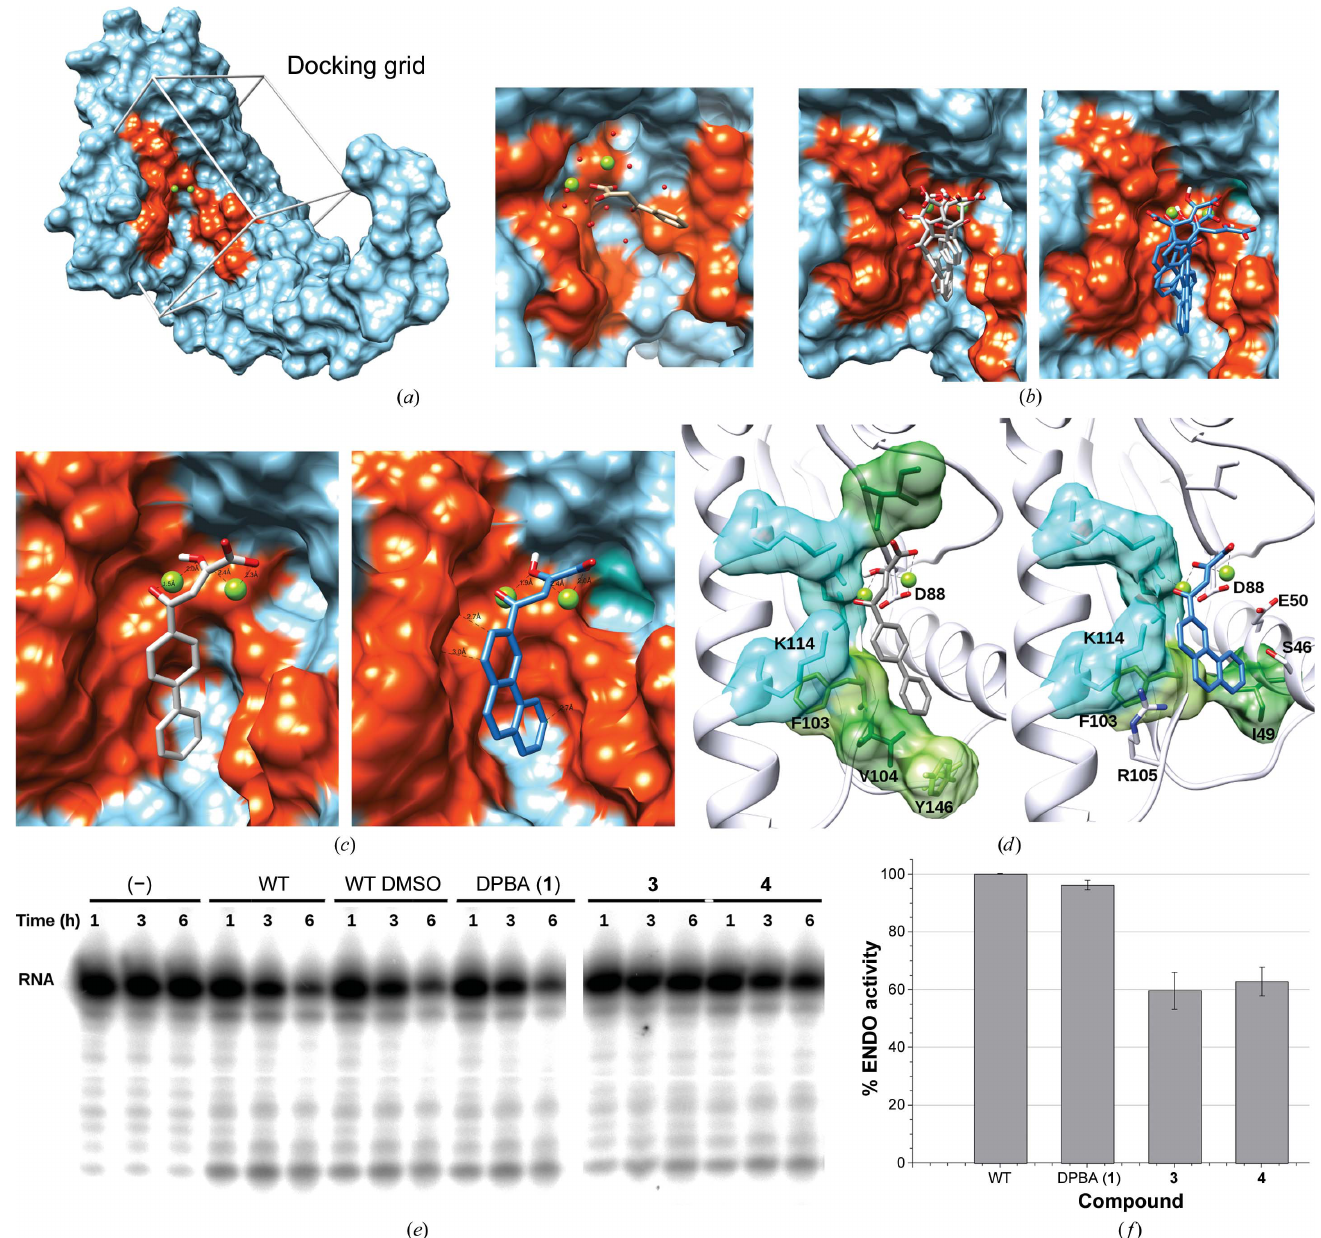
Figure 5 ( a ) Structure of ENDO-WT complexed with Mg ions and the docking grid. The surface is coloured cyan and the conserved motif is coloured orange. Mg 2+ ions are represented as light green spheres. The position of DPBA ( 1 ) is shown in the right panel. ( b ) Selection of the best docking poses of compounds ( 3 ) and ( 4 ). ( c ) Enlargement of the best pose on the cavity surface. ( d ) Enlargement of the best pose with the residues involved in binding. These are coloured according to hydrophobicity from cyan (least) to green (most). ( e ) Polyacrylamide/8 M urea gels of compounds ( 3 ) and ( 4 ) (50 m M ) incubated with 20 m M protein and 1 m M single-stranded RNA. ( f ) Quantification of endonuclease activity in the presence of DMSO and compounds ( 1 ), ( 3 ) and ( 4